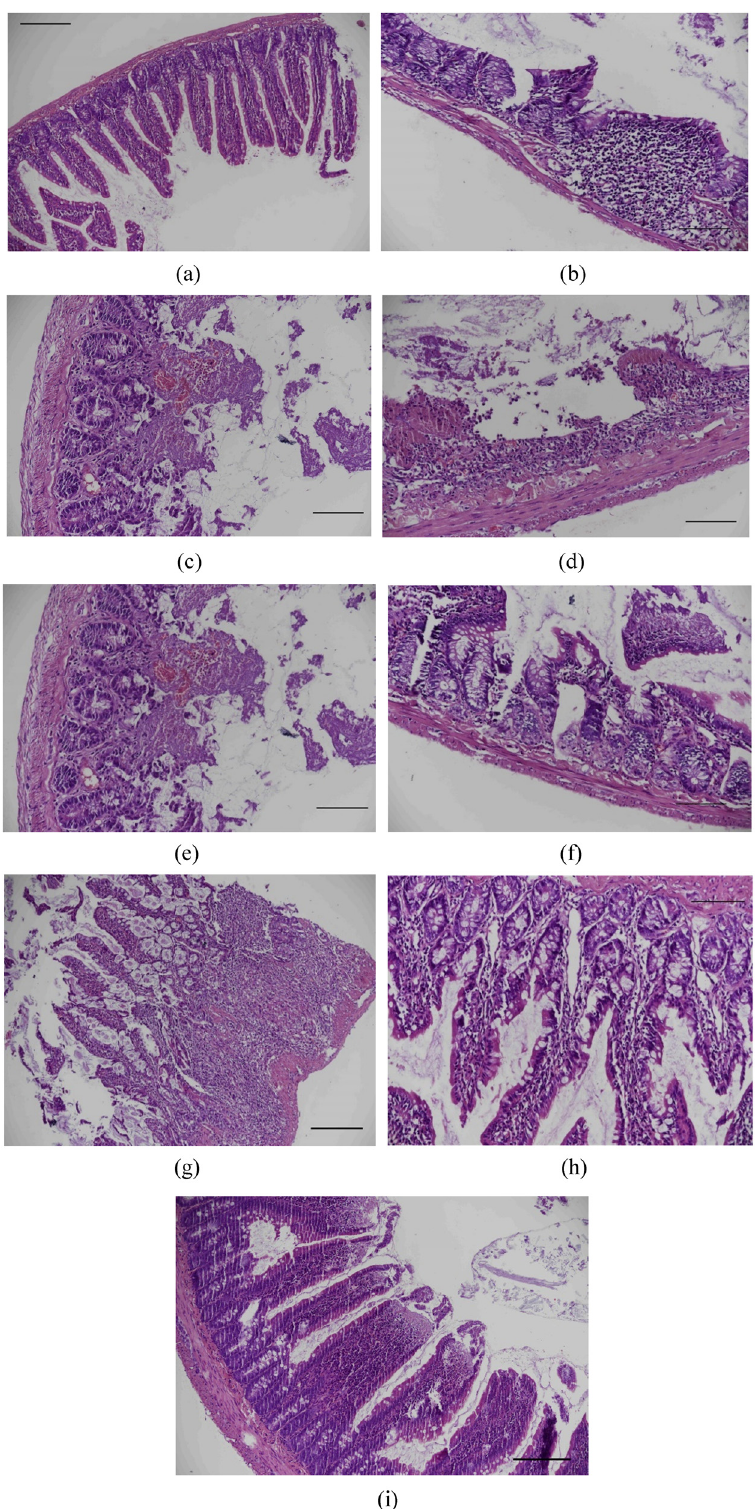
Figure 6: Photomicrographs of ileal sections stained with HE. ( a ) The ileum samples from the control group showed regular morphology and revealed minimum Chiu score of 0. ( b and c ) The ileum samples from the AM - treated rats showed slight thickening and irregularity in some villi, light epithelial lift in the apical regions of some villi, minimal degenerative changes in the epithelial cells, generally normal scattered goblet cells, and revealed Chiu score of 1 and 2. ( d – f ) The ileum samples from the IR group showed thickened and irregular villi, heavy degenerative changes in the epithelial cells, breakage in the epithelial cells, decrease in the goblet cells and mucins, capillary congestion in the villus, denudation of the Lieberkühn crypts, intense in fl ammatory cells, ulceration, and revealed maximum Chiu score of 5. ( g – i ) The ileum samples from the AM + IR group showed thickened and irregular villi, lifting of epithelial layer from the lamina propria, increase in the goblet cells and mucins, and revealed Chiu score of 3; ( a, c, g, and i: Scale bars: 200 μ m, b, d, e, f, and h: Scale bars: 100 μ m )